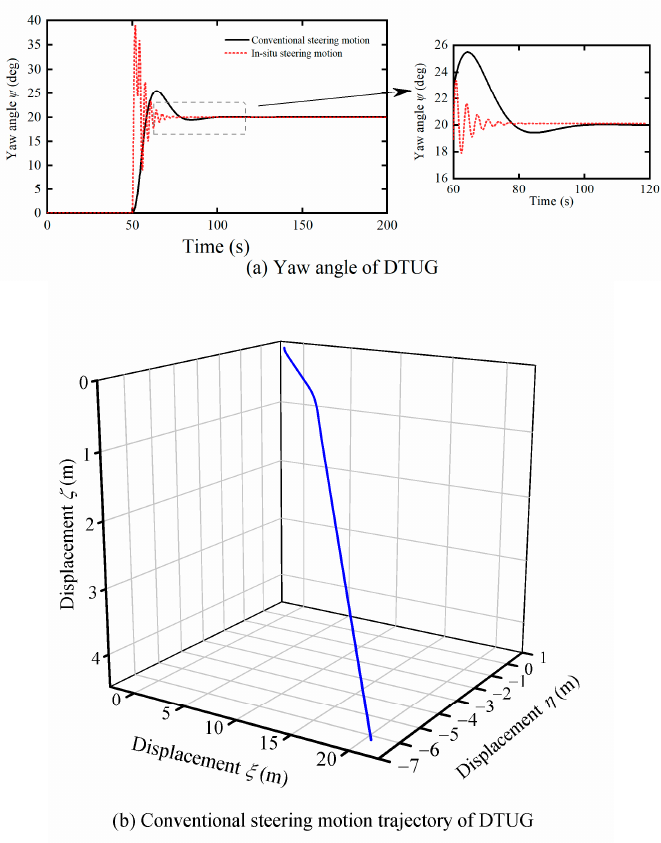
Figure 10. Yaw angle and motion trajectory of DTUG.